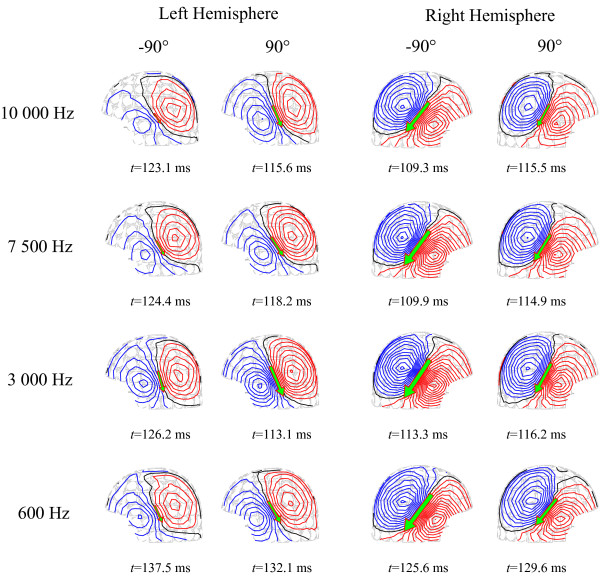
Representative N1m responses. Equivalent current dipoles (ECDs) calculated for the grand-averaged N1m response at the average peak latency t. The figure shows ECDs for stimuli with different bandwidths originating from directions -90° and 90°, calculated separately for the left and right hemisphere (contour step 20 fT/cm).